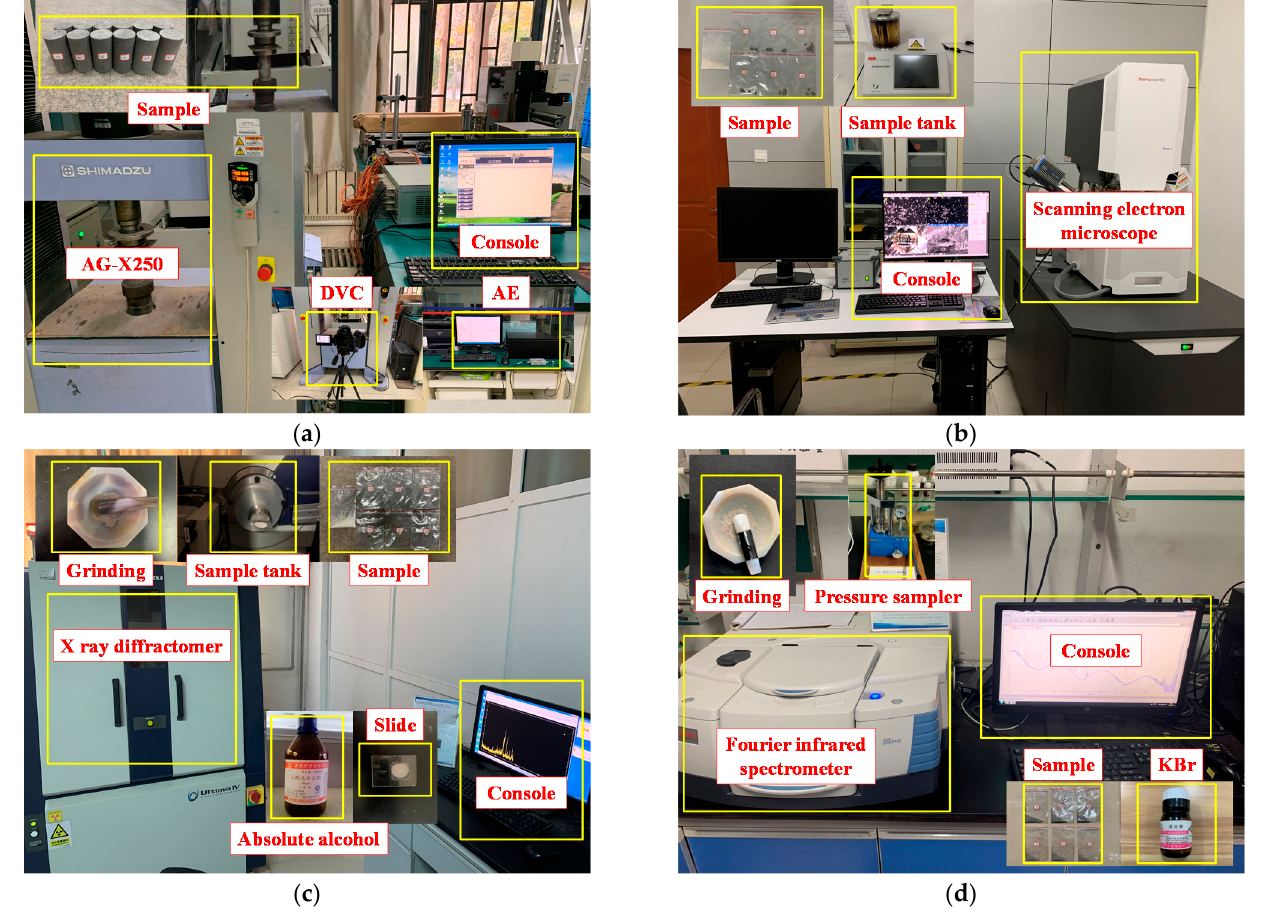
Figure 4. Experimental testing system. ( a ) Uniaxial compression tests; ( b ) SEM experiment; ( c ) XRD experiment; ( d ) FTIR experiment.